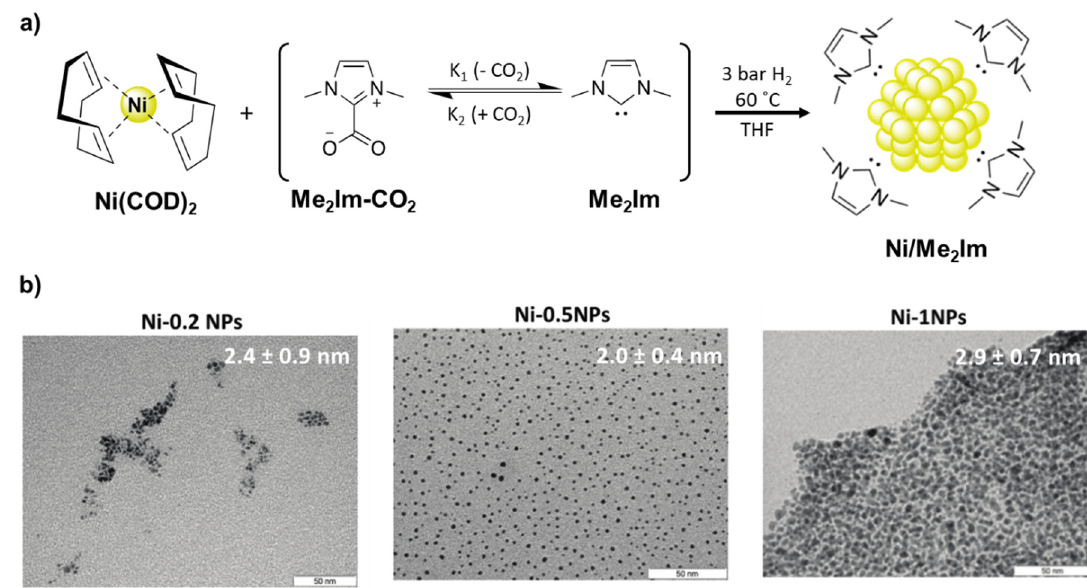
Figure 5. ( a ) Synthesis of Ni / Me 2 Im as an example of NHC-based organometallic MNP from imidazolium carboxylate. ( b ) TEM images and size distribution of Ni 0.2 , Ni 0.5 y Ni 1 / Me 2 Im NPs. Adapted from reference 49. Copyright 2017 The Royal Society of Chemistry.